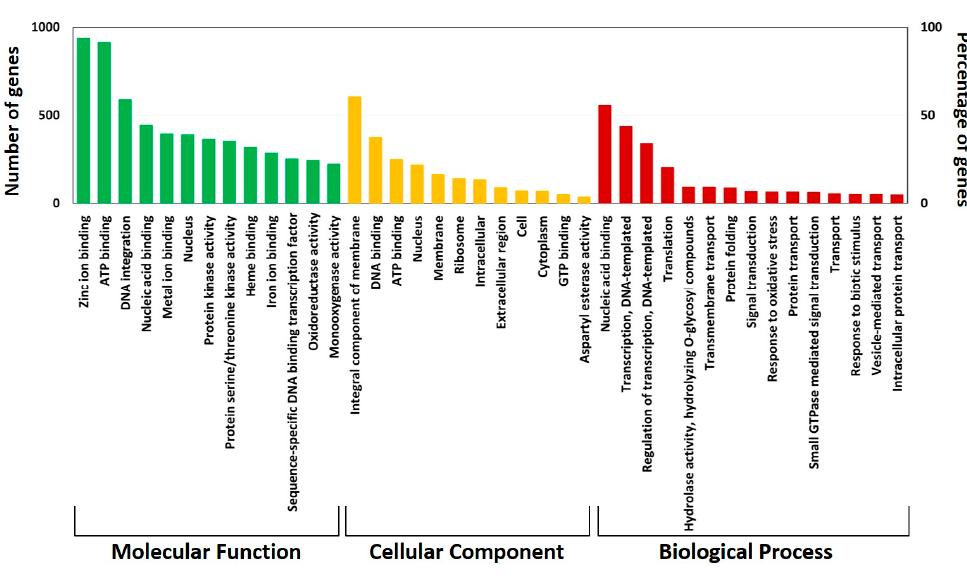
Figure 2. The bar chart depicts the top 15 Gene Ontology (GO) annotation categories, including molecular function (in green color), cellular component (in yellow color), and biological function (in red